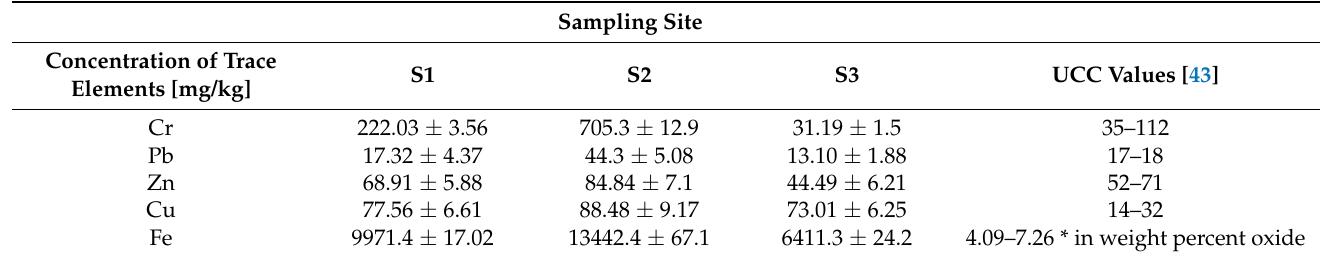
Table 4. The mean concentrations of the selected toxic metals in the sediments ± SD for sites: S1 “Bł˛ekitna Laguna”, S2 “Huta”, and S3 “Mała Szwecja” [mg/kg]. * The content of Fe was expressed as FeO in weight percent oxide, as this is one of the major elements.